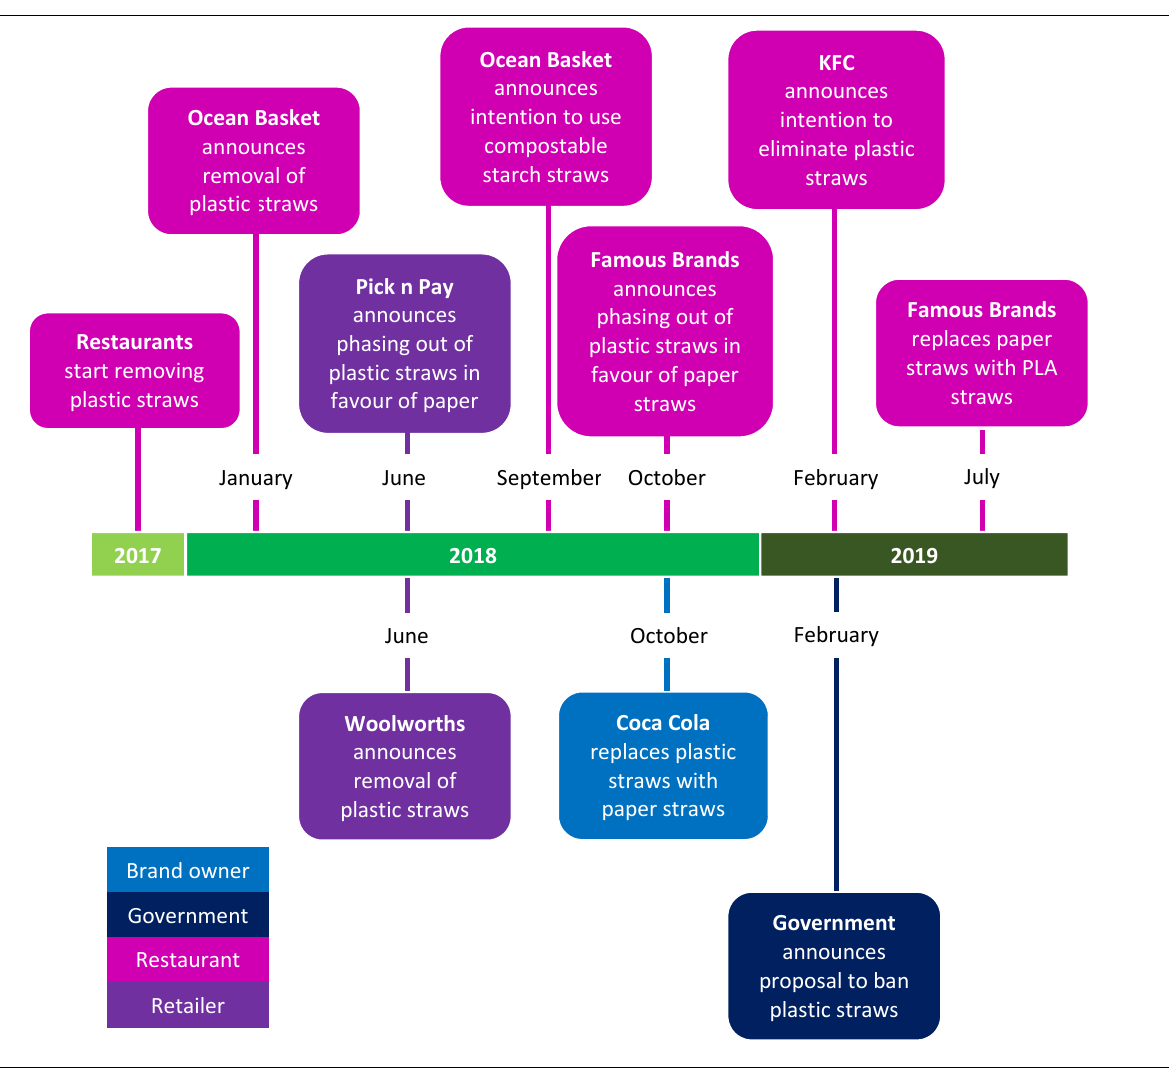
Figure 1: Timeline of responses of value-chain actors in South Africa to plastic straw